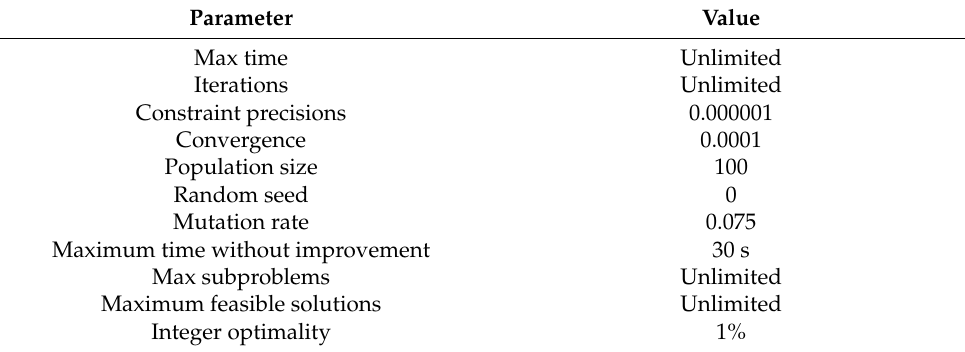
Table 1. Parameters used for optimization in the